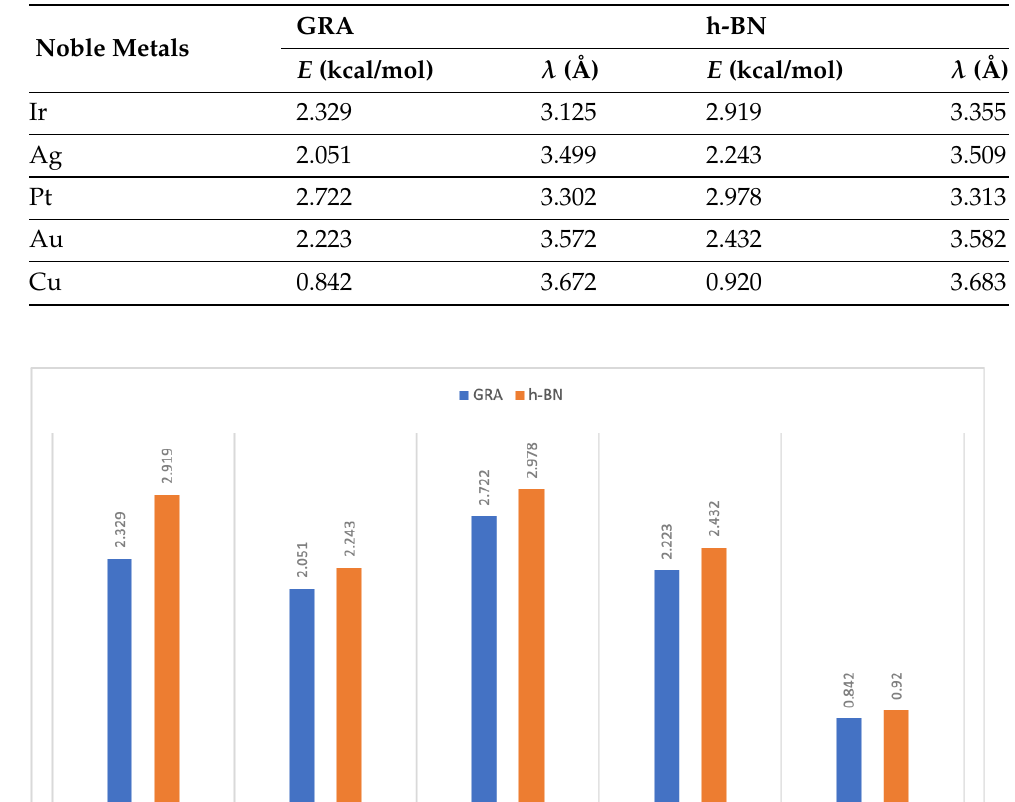
Figure 3. Interactions between noble metals and nanosheets with respect to the perpendicular distance λ . Table 2. Main results of the binding energies E and equilibrium distances λ .